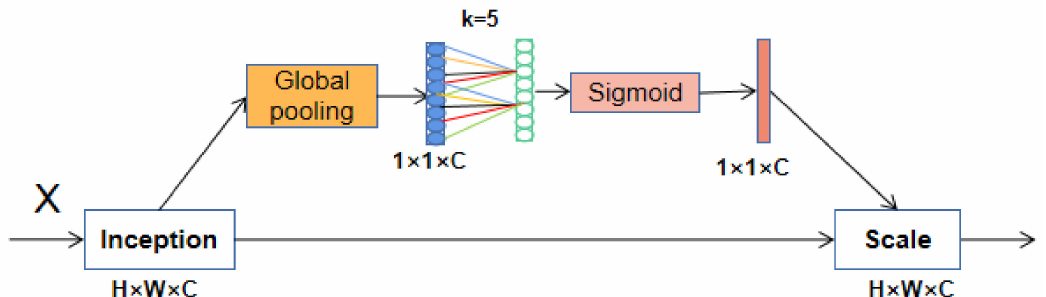
Figure 5. ECA block